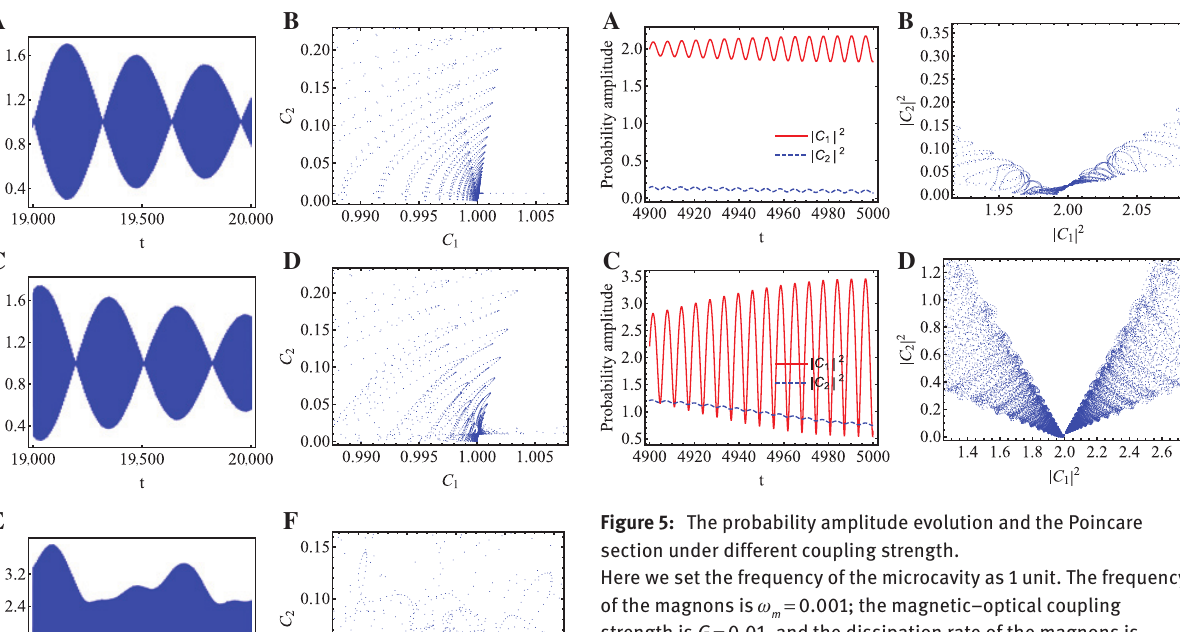
Figure 4: The probability amplitude evolution of C section under different coupling strengths.